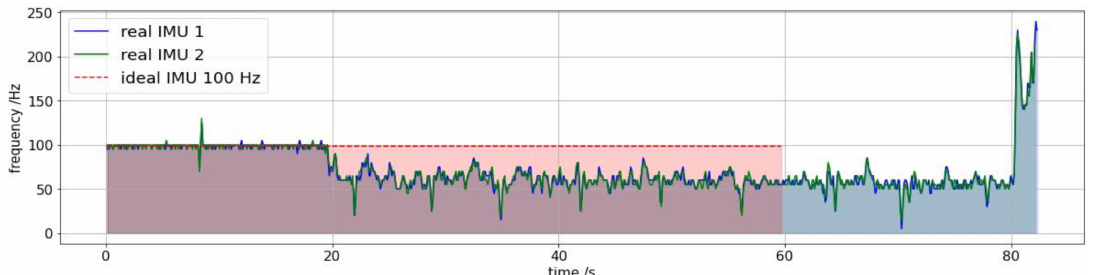
Figure 6. Real and ideal sampling rate of a IMUs experiment at 100 Hz with a computer that is simultaneously recording video with Kinect v2. The real signal must be corrected due to the lag that results from the lack of computer processing